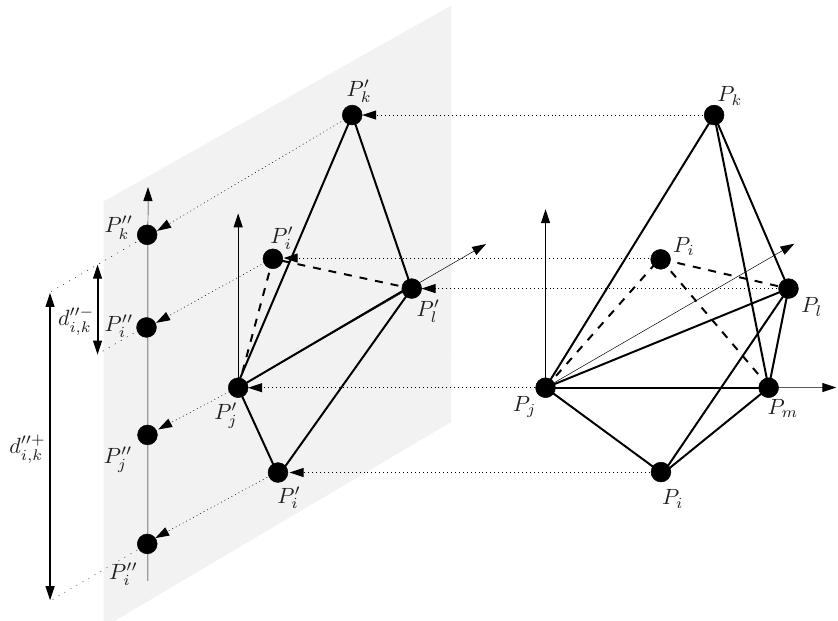
Figure 1. Schematic illustration of the projection and back-projection range reduction procedure proposed in this paper. See the text for details.